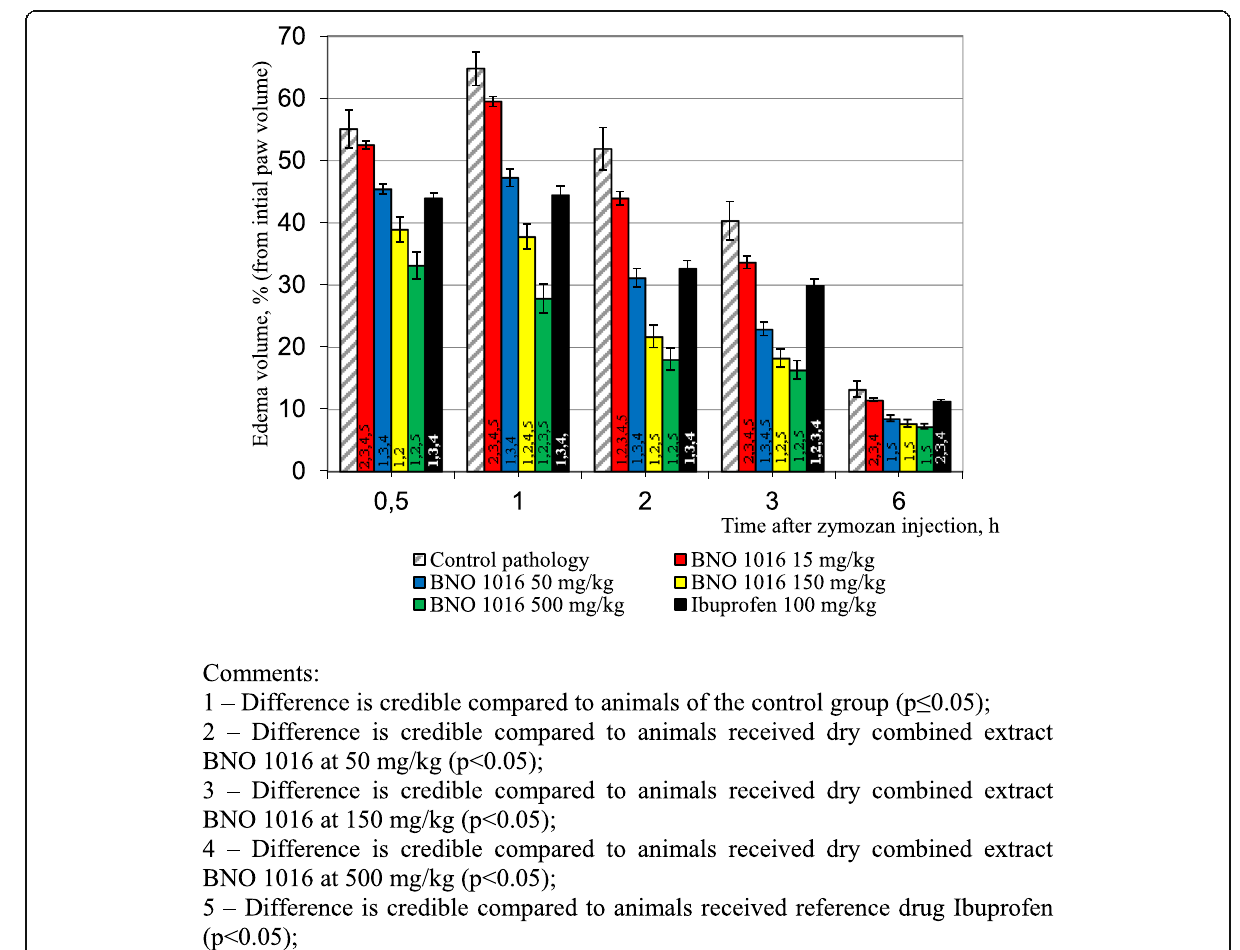
Fig. 1 Effect of dry combined extract BNO 1016 on edema